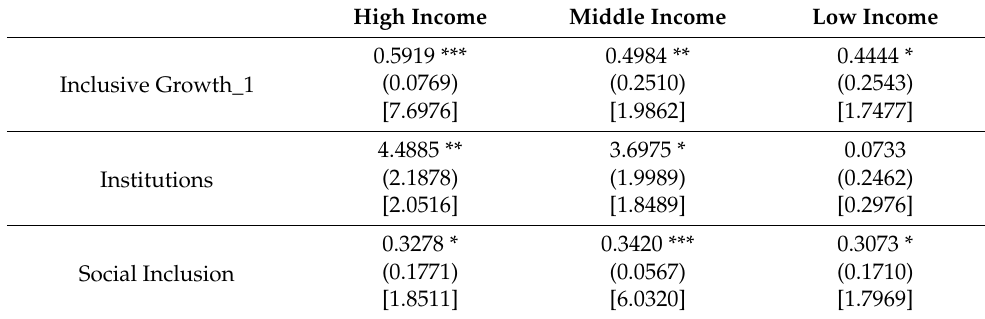
Table 2. Results for the impact of CO 2 on inclusive growth with social inclusion * CO 2